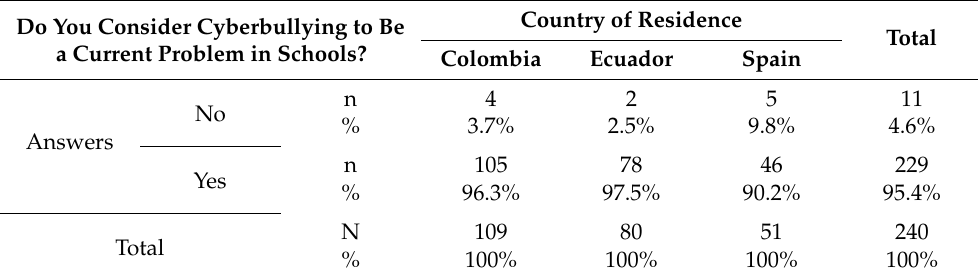
Table 9. Cross-categorization of the variable “Do you consider cyberbullying a current problem in schools?” and the variable “Country of